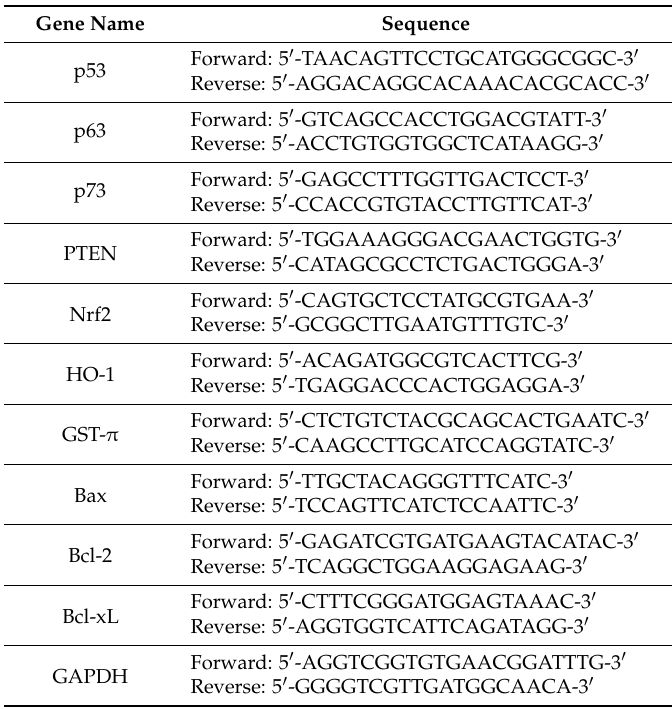
Table 1. Sequences of primers used in this